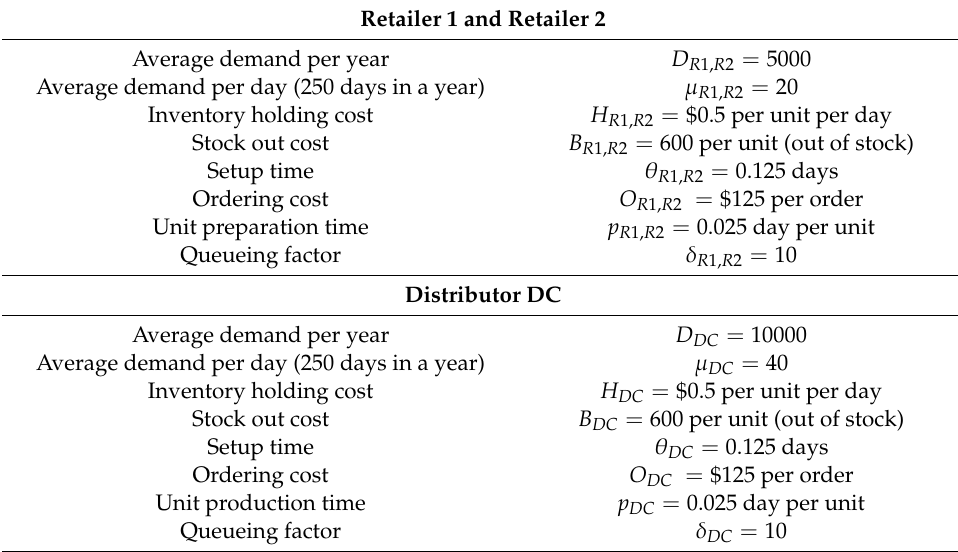
Table 3. Data of Retailer 1, Retailer 2, and